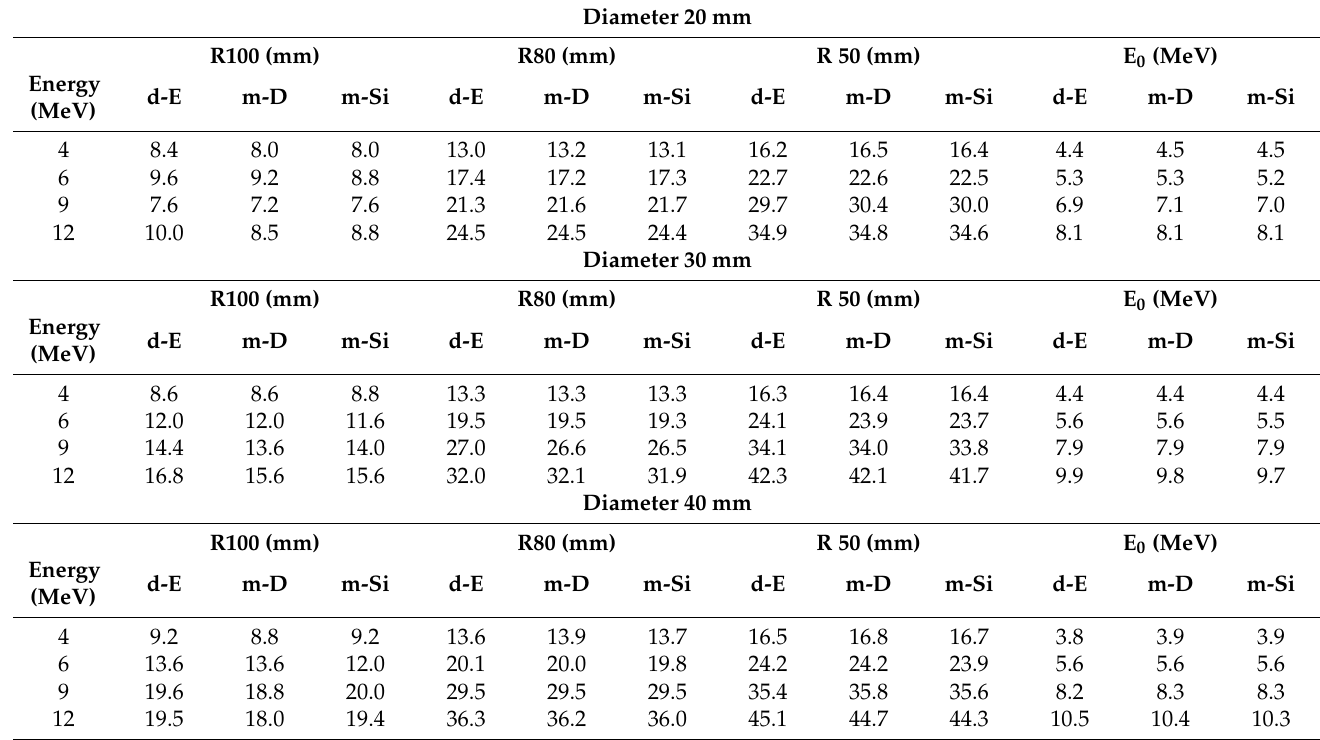
Table 3. Most relevant dosimetric parameters derived from PDD curves for all tubular